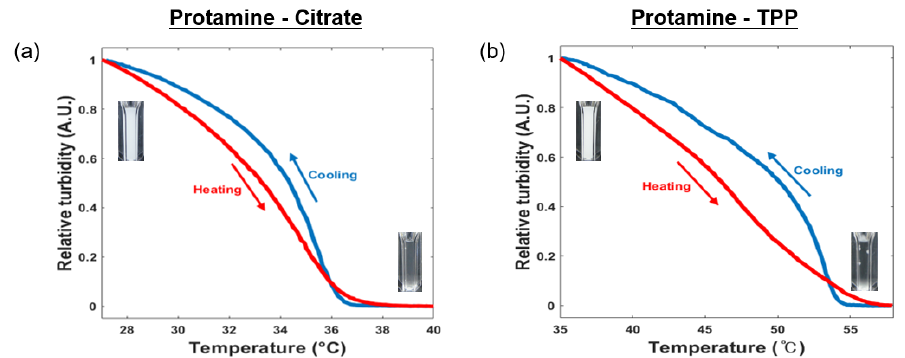
Figure 3. Temperature-dependent coacervation of protamine and multivalent ion mixtures. Turbidity measurements of the ( a ) protamine / citrate mixture and ( b ) protamine / TPP mixture at 600 nm with respect to temperature. The total polyelectrolyte concentration ( C p ) was fixed to 1% ( w / v ), and the weight ratio between protamine and multivalent ions was fixed to 6:4. Inset images show reversible phase transitions of the coacervates by temperature cycling.